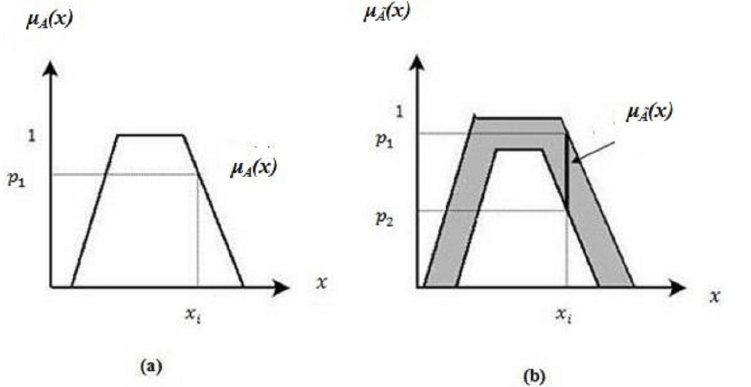
Figure 1. ( a ) Crisp grades of membership for type-1 fuzzy sets (T1FS) A ; ( b ) Fuzzy grades of membership for IT2FS ˜ A